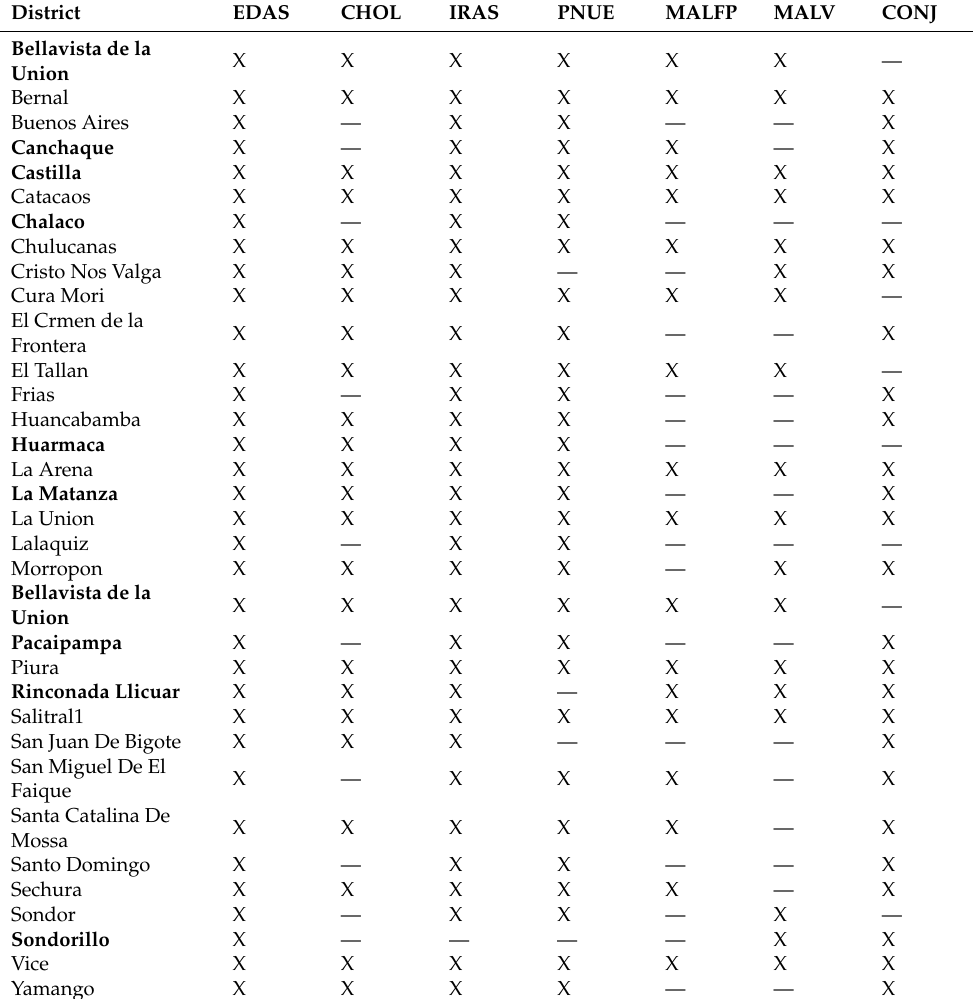
Table A2. Presence of diseases by district (Week 9